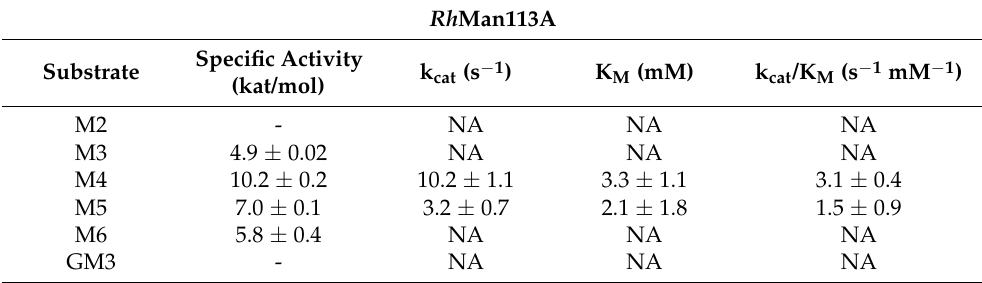
Incubations were at 30 ◦ C in 50 mM phosphate buffer. The assay time was 10 min for specific activity analysis and 30 min for Michaelis–Menten kinetics. NA, not analyzed; “-”, no detectable activity. Data from triplicate incubations and mean values ± SD (standard deviation) are